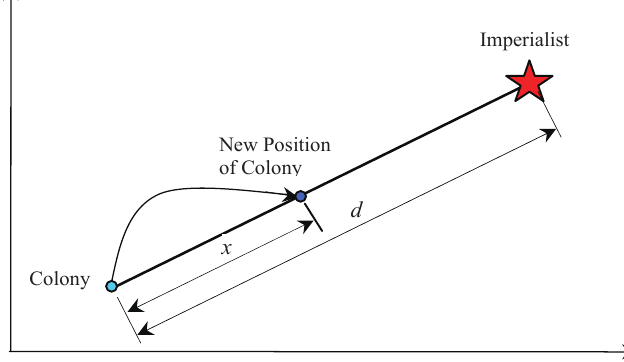
Fig. 1. Movement of colonies toward their relevant